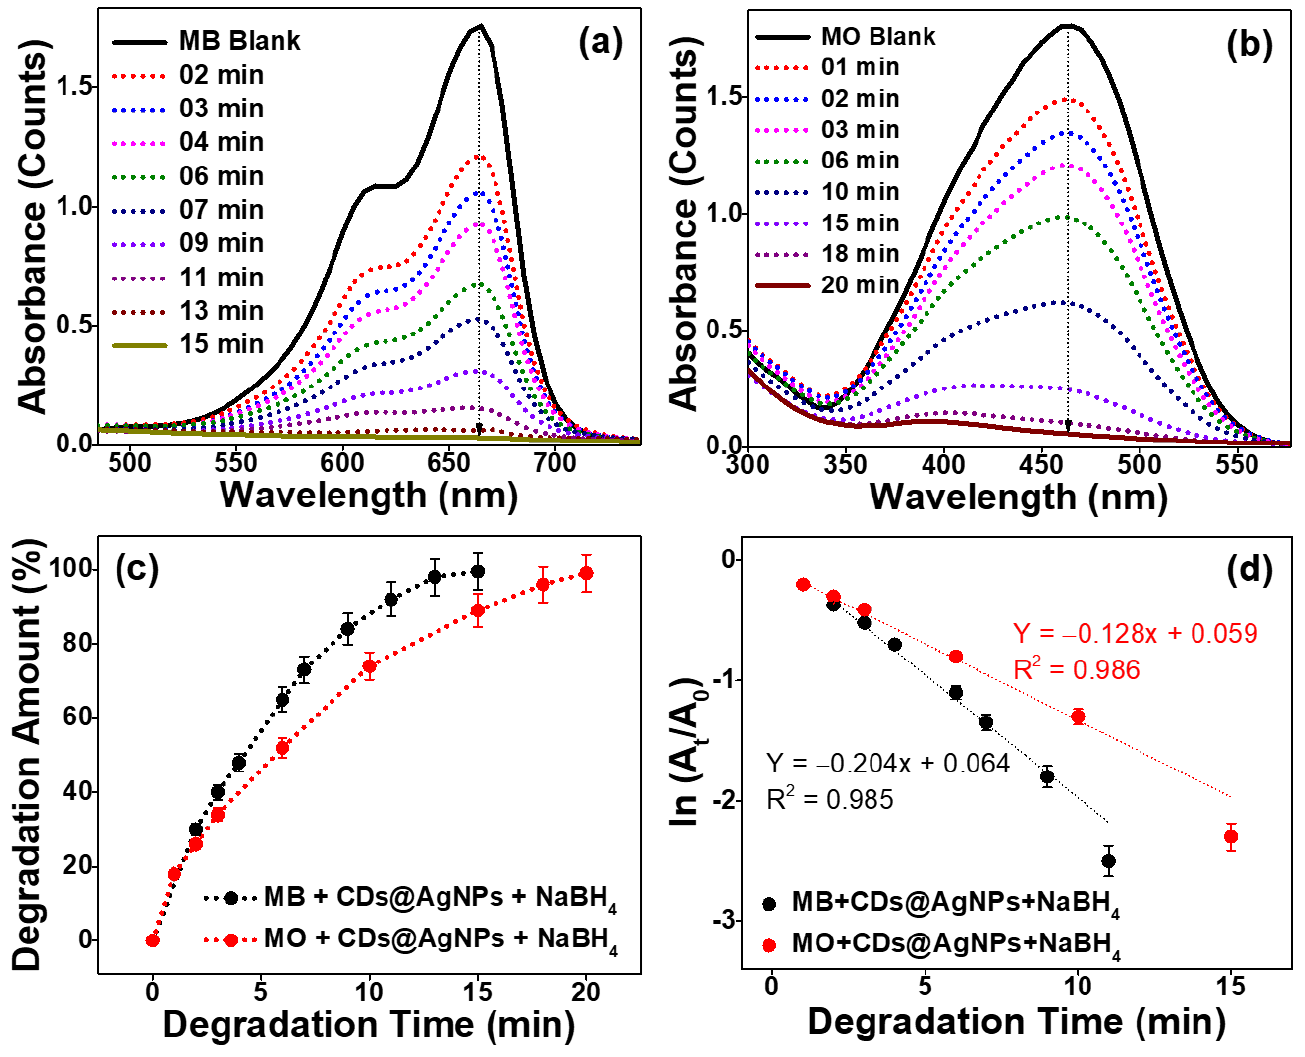
Figure 5. UV-vis absorbance spectra of ( a ) MB and ( b ) MO aqueous solutions in the presence of the CDs@AgNP composite and NaBH 4 at different degradation times, ( c ) degradation efficiencies (%) of the synthesized CDs@AgNP composite against MB and MO dye solutions, and ( d ) pseudo-first-order kinetic plots of the degradation of the MB and MO dyes. Table 1. Comparison of the catalytic performances of AgNP-based composites from bio-sources.